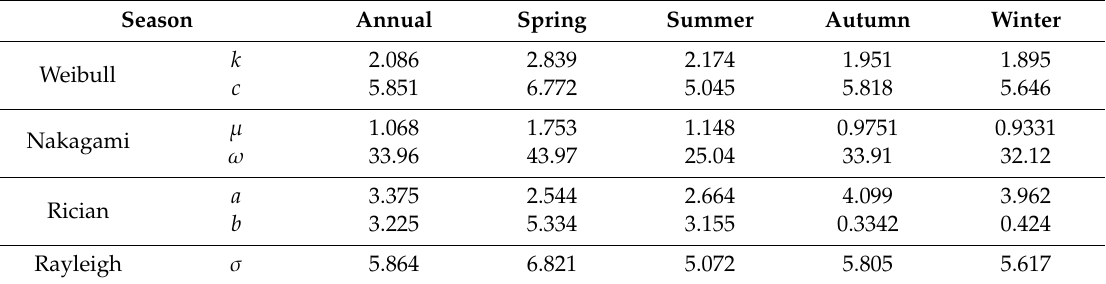
Table 6. Parameters of corresponding distributions based on annual and seasonal wind data. Season Annual Spring Summer Autumn Winter